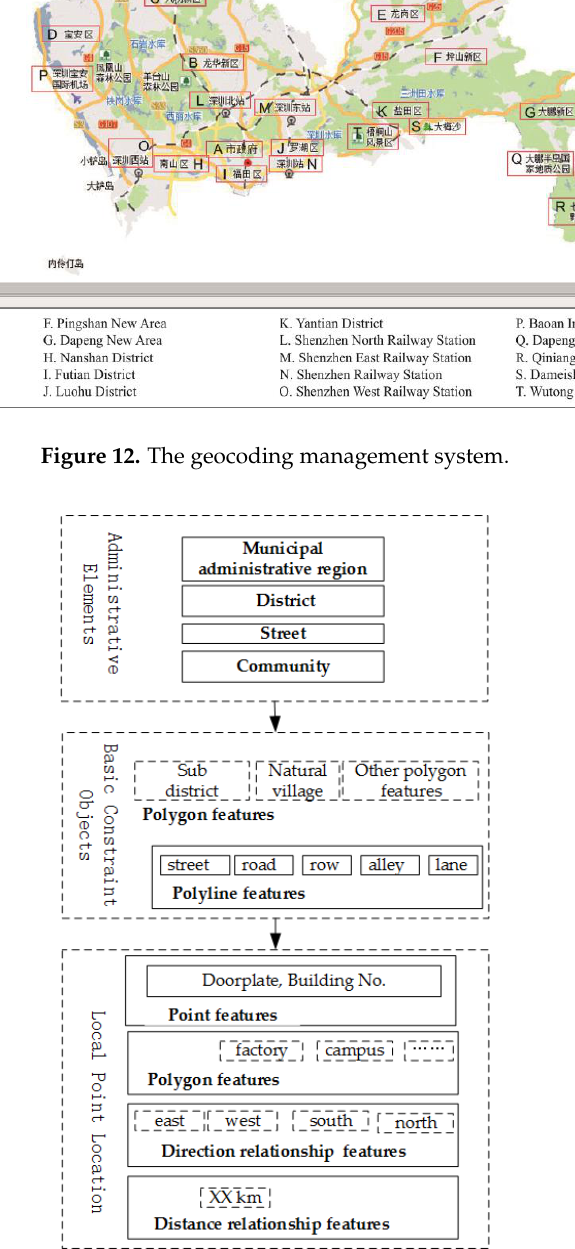
Figure 13. Address Model for Shenzhen.